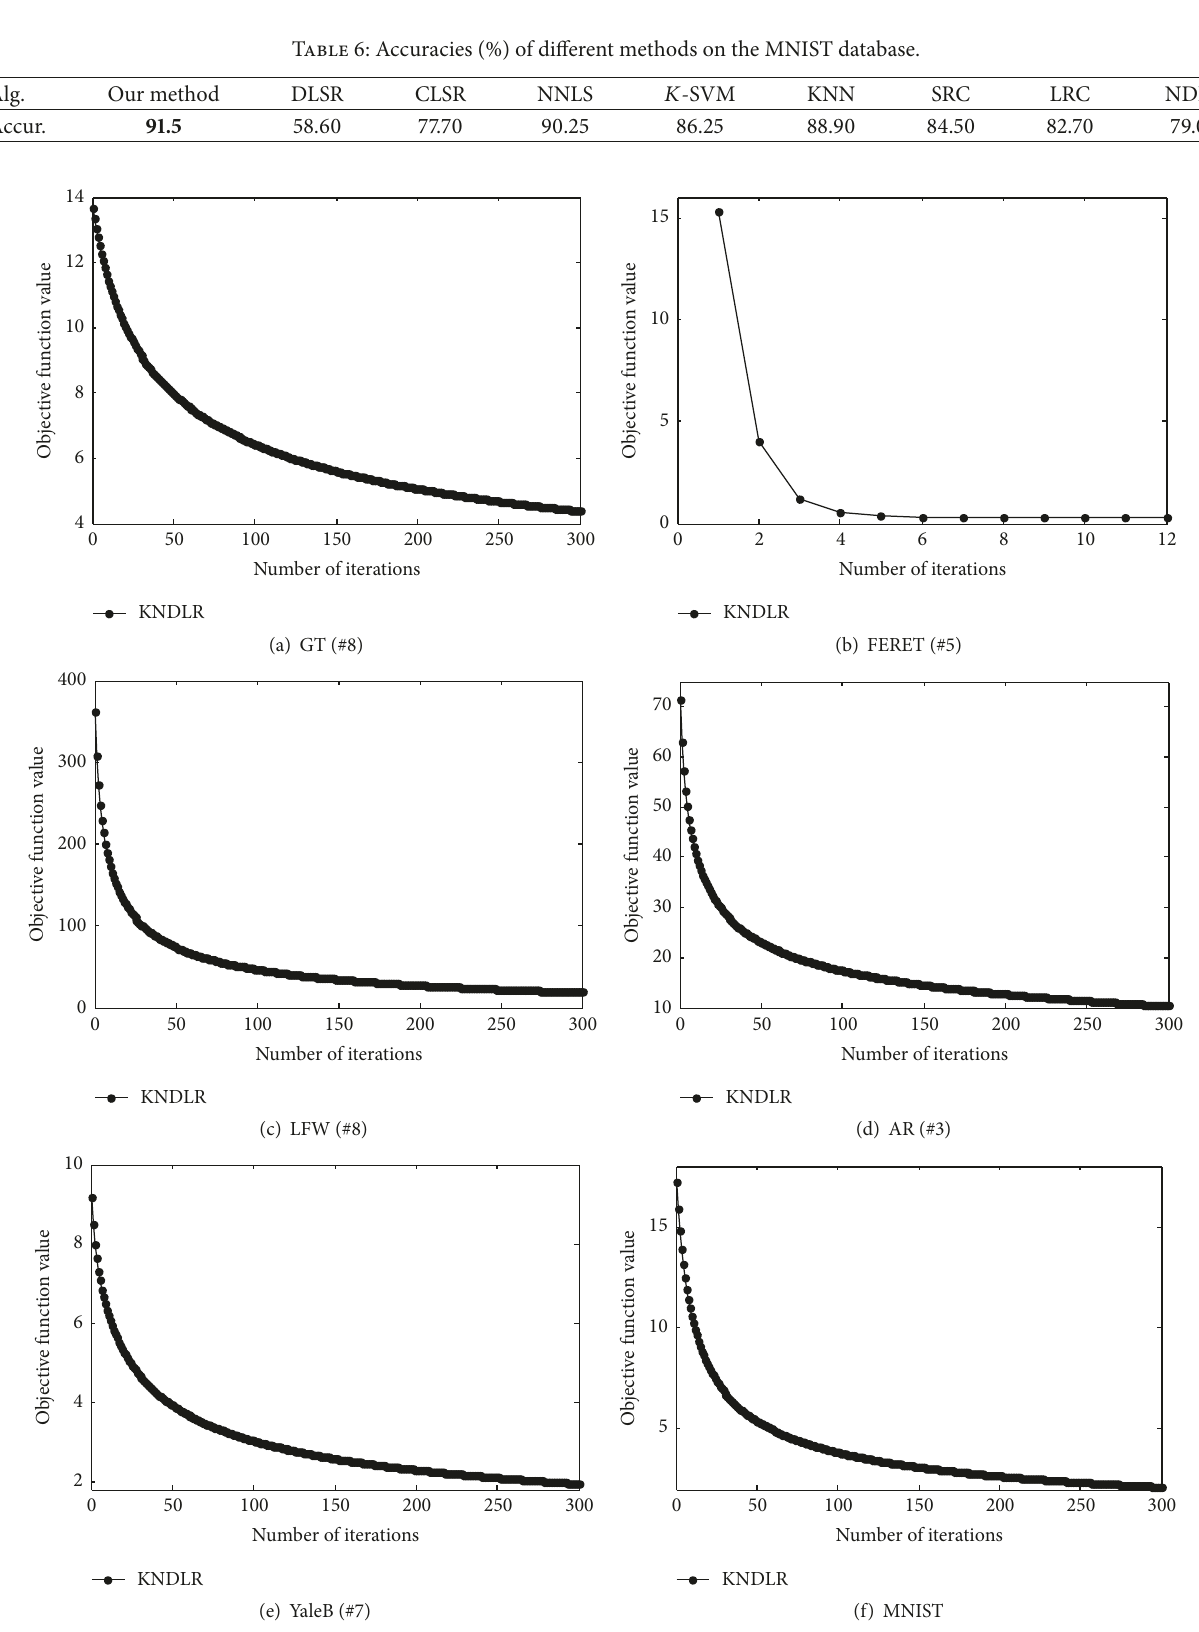
Figure 8: Convergence curves of KNDLR on the six